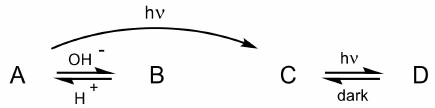
Scheme 3. Complete interconversion between forms A, B, C, and D in